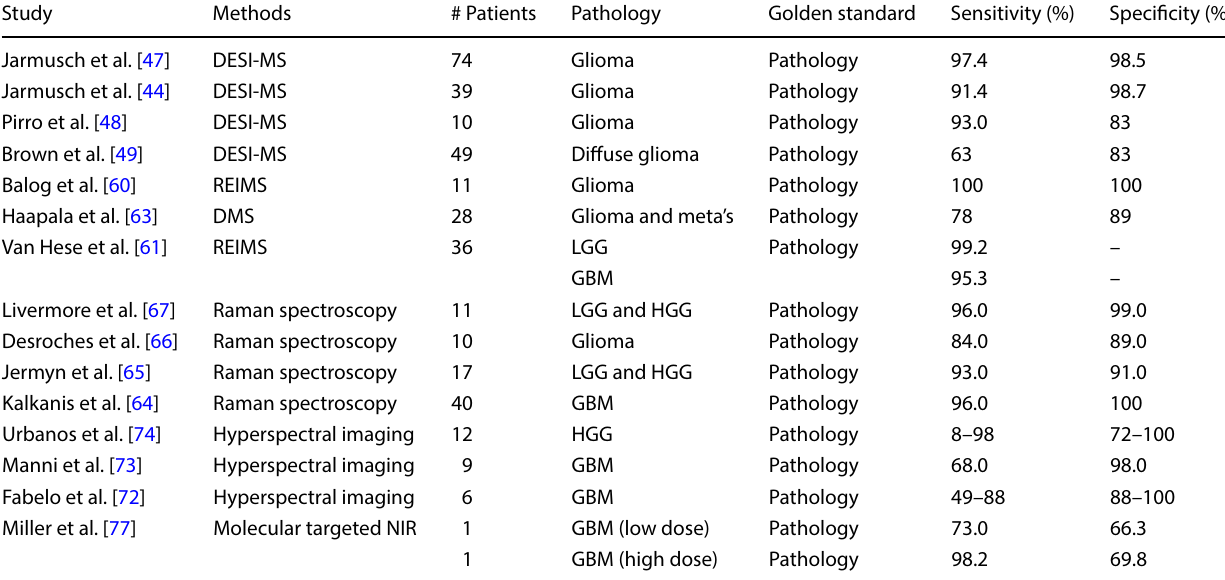
Table 3 An overview of studies evaluating the sensitivity and specificity of experimental techniques for the characterisation of brain tumours